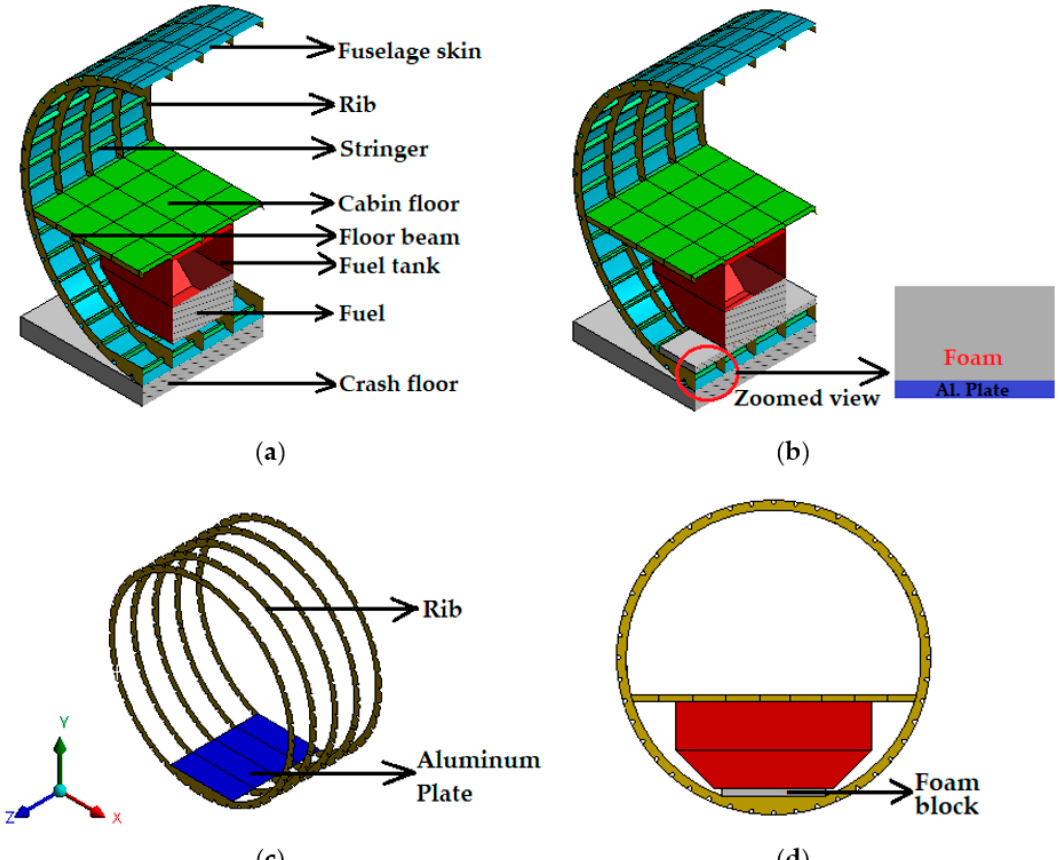
Figure 1. Geometric model of the fuselage section: ( a ) Traditional design; ( b ) Proposed reinforced design; ( c ) Skeleton view of the proposed model with aluminum plate; ( d ) Front view of the pro- posed model.